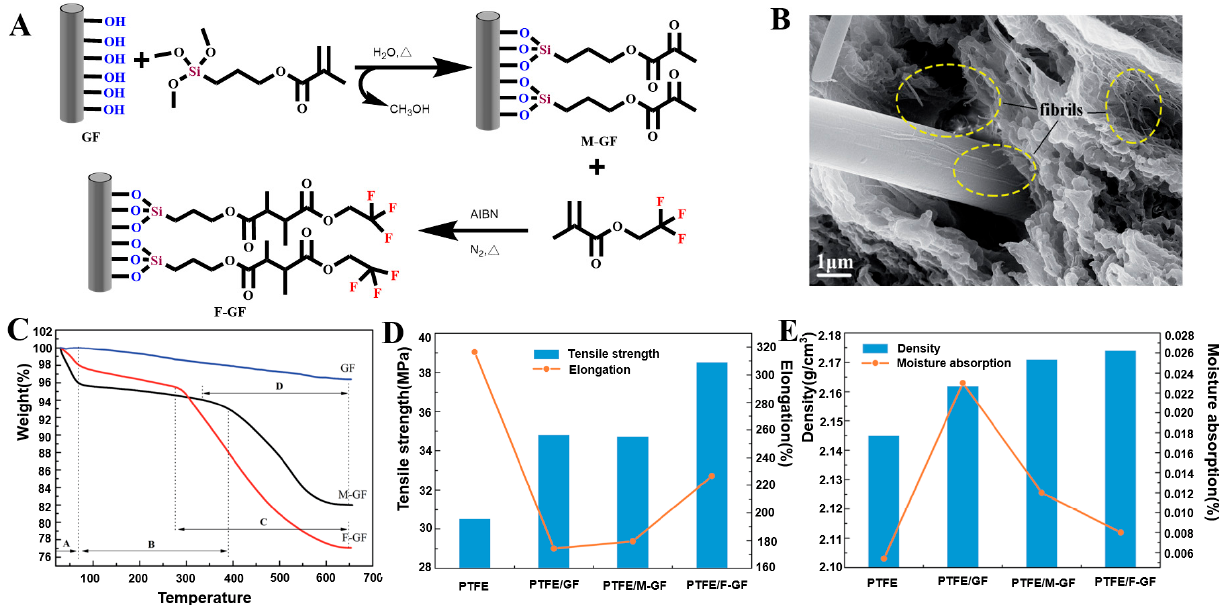
Figure 17. ( A ) The strategy for the surface fluorination of glass fiber. ( B ) The fibrils structure in PTFE/F-GF after a tensile fracture. ( C ) TG curves of GF, M − GF, and F − GF. ( A ) Residual solvent desorption; ( B ) physisorbed water desorption; and (C and D) modifier loss. ( D ) The tensile strength and elongation of PTFE, PTFE/GF, PTFE/MGF, and PTFE/F − GF. ( E ) The density and moisture ab- sorption of PTFE, PTFE/GF, PTFE/M − GF, and PTFE/F − GF. Reproduced with permission from ref- erence [127]. Copyright 2017 RSC Advances